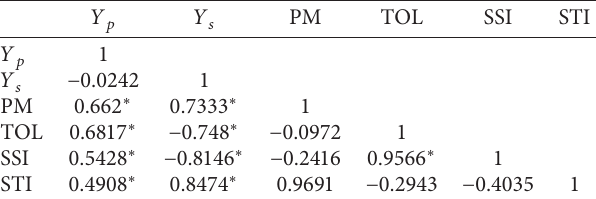
Table 4: Correlation between drought tolerance indices and seed yield under nonstressed and water deficient stressed